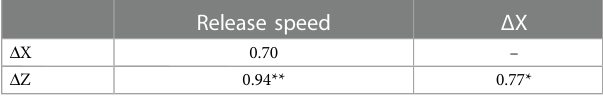
TABLE 3 Correlation coef fi cient between release speed and Δ X and Δ Z from all pitch types.